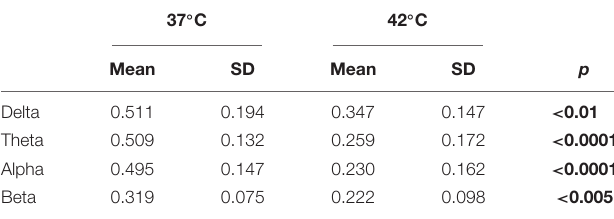
Statistically significant values are marked in bold. TABLE 2 | Average of the normalized power for different frequency bands as a function of the temperature and p -values obtained by comparing 37 ◦ C with 42 ◦ C with a permutation test ( n = 20,000